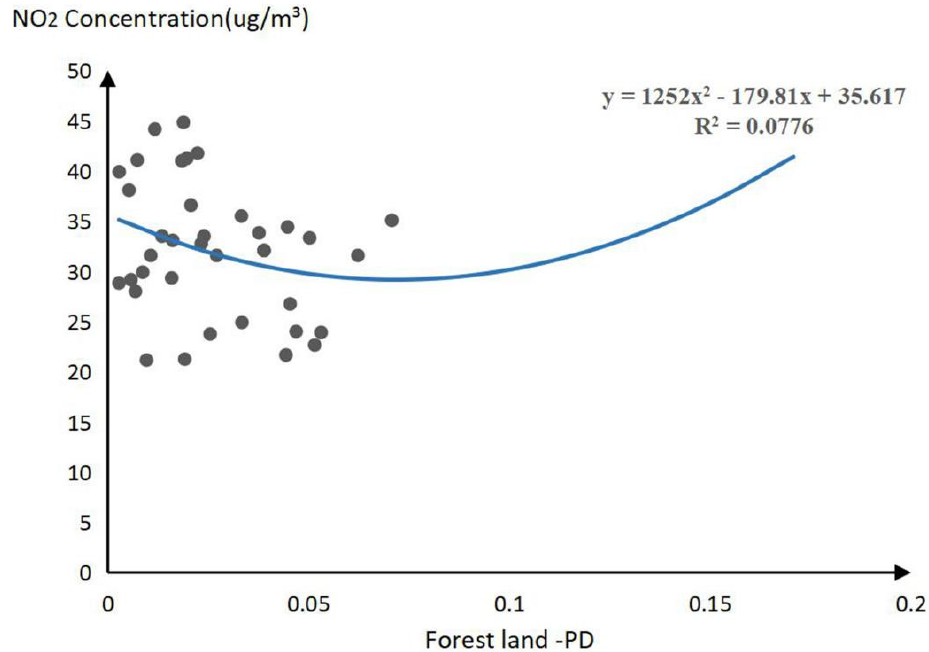
Figure 2. Threshold of significant landscape pattern indices for NO 2 pollutant.